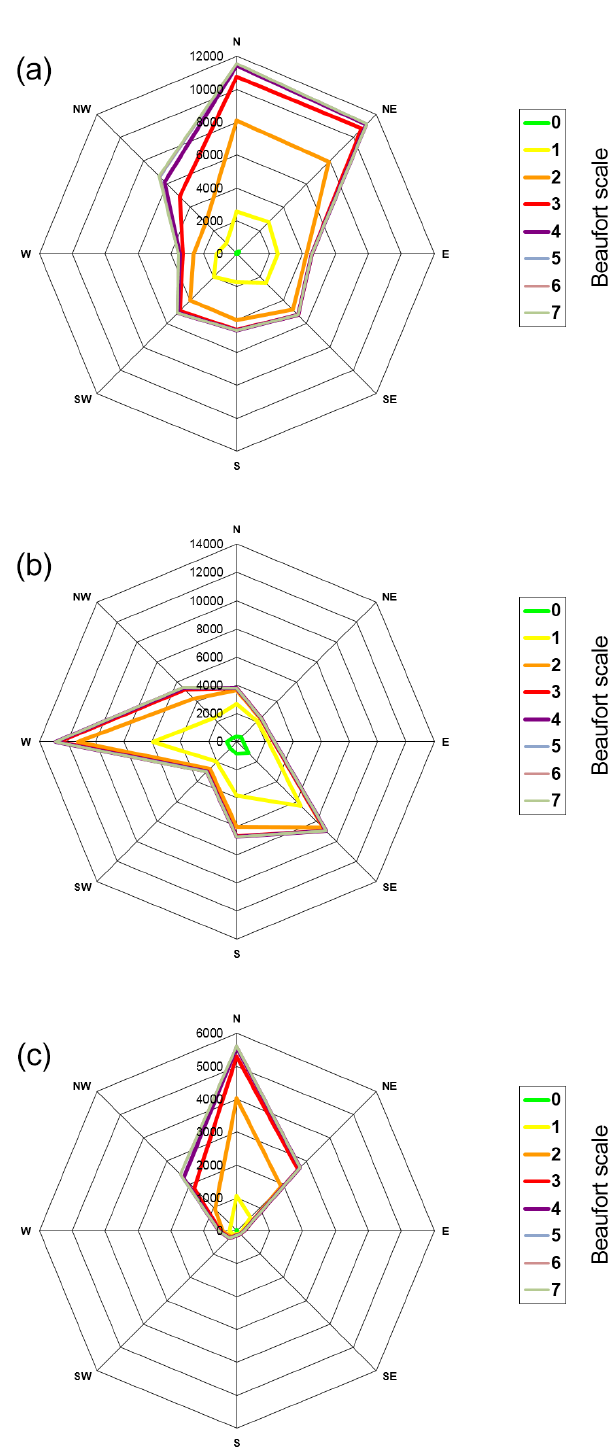
Figure 5. Wind roses based on the modern Beaufort scale for the data sets obtained above the rooftop level of the building (a) , on- site the BpART facility (b) , and for the data above the rooftop level on the condition that the WD on-site was W and its speed >0.3ms − 1 (c) . Figures on the vertical axis indicate the scale for the number of data belonging to each